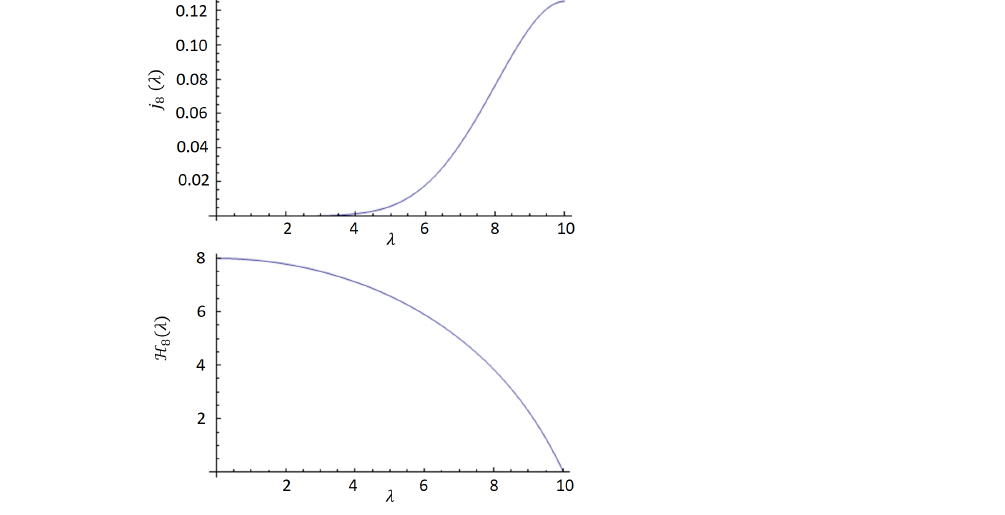
Figure 6. The decreasing positive function H 8 ( λ ) and the subsequent spherical Bessel function j 8 ( λ ) . Table 1. Some characteristic cones for several values of the parameter m